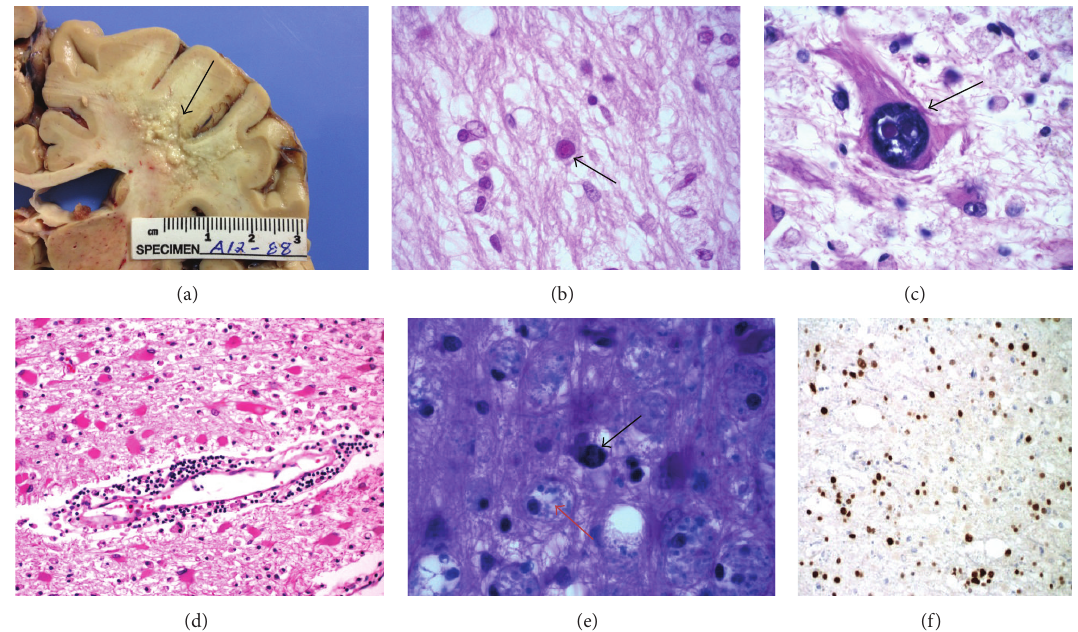
Figure 2: (a) PML gross pathology finding, right frontoparietal white matter lesion (black arrow). The subcortical whiter matter shows an irregular disruption measuring 1 × 1.5cm. (b) Viral inclusions in an enlarged oligodendroglial nucleus (black arrow). (c) Bizarre reactive astrocyte with enlarged nucleus and prominent nucleolus. (d) Perivascular cuffing by lymphocytes. (e) Luxol Fast Blue/H&E stain showing an intranuclear inclusion (black arrow) and numerous foamy macrophages containing myelin debris (red arrow). (f) Immunocytochemistry using target-antibody against SV40, showing numerous positively stained